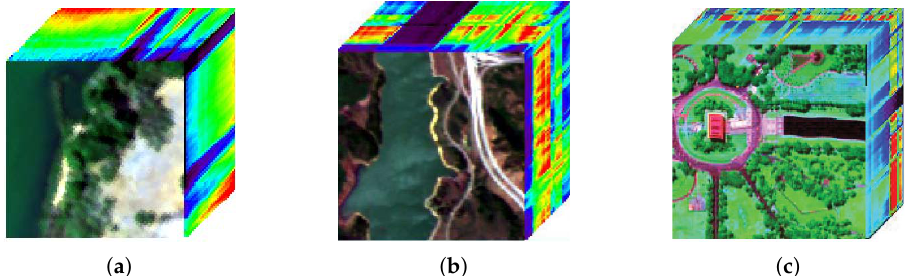
Figure 2. Pseudo-Color images of three real hyperspectral image datasets. ( a ) Samson ; ( b ) Jasper Ridge ; ( c ) Wash. DC Mall